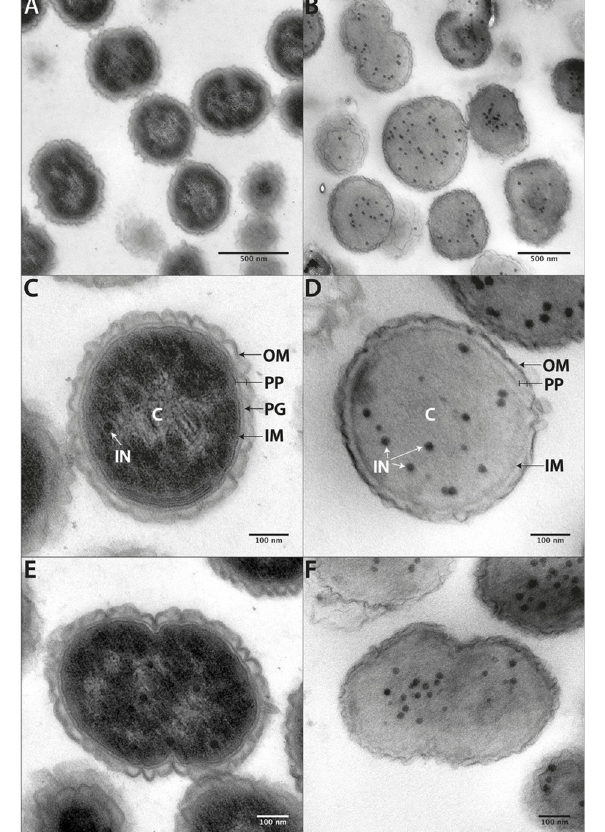
resin embedding and ultrathin sectioning of V. parvula